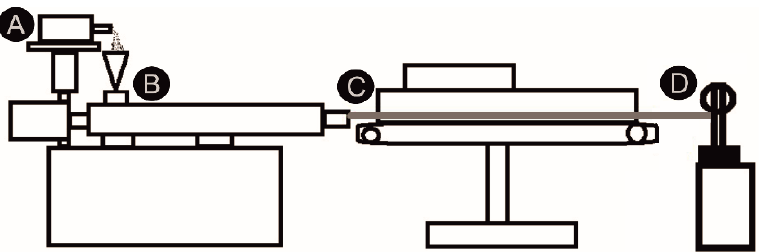
Figure 15. Technical drawing of an extrusion line as used for the production of PEU filaments: material feeding system ( A ), twin-screw extruder ( B ), conveyor belt ( C ) and filament winding machine ( D ). The extrudate is drawn in gray color.